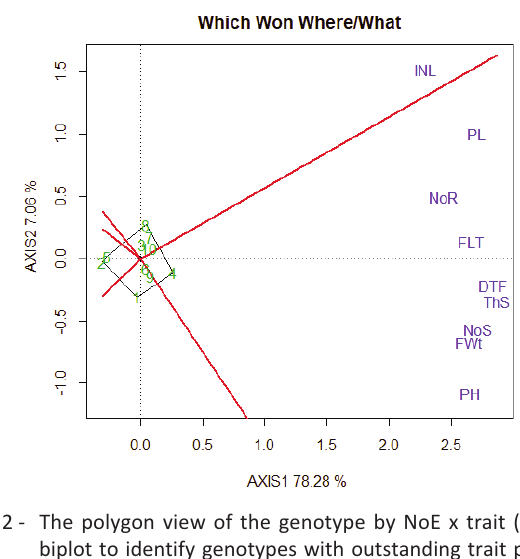
Fig. 2 ­ The polygon view of the genotype by NoE x trait (GYT) biplot to identify genotypes with outstanding trait profi­ les.